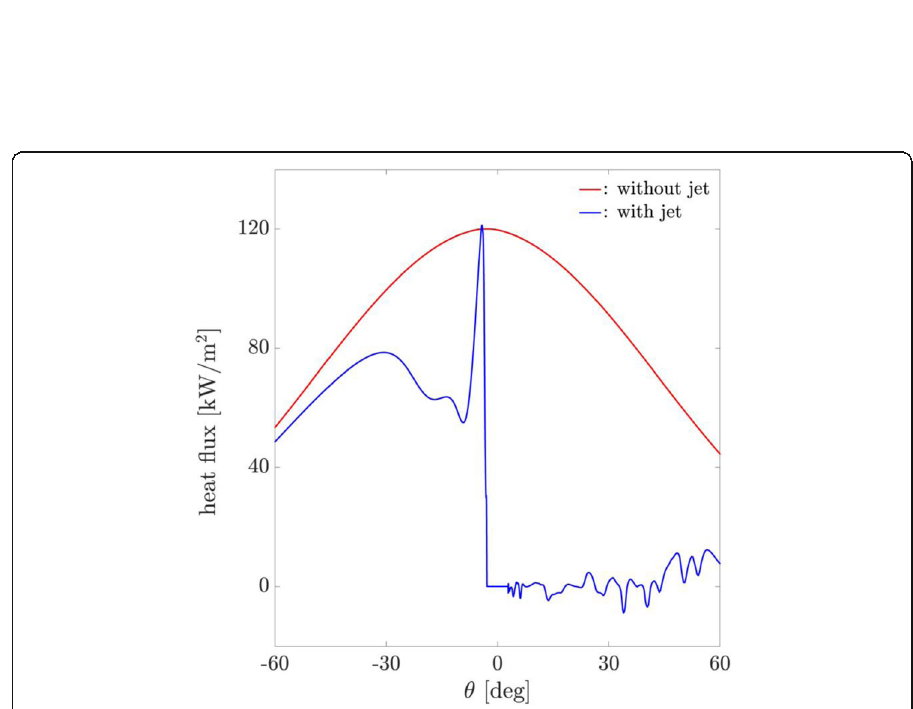
Fig. 7 The distribution of the heat flux along the cylinder corresponding to the temperature field shown in Fig. 6